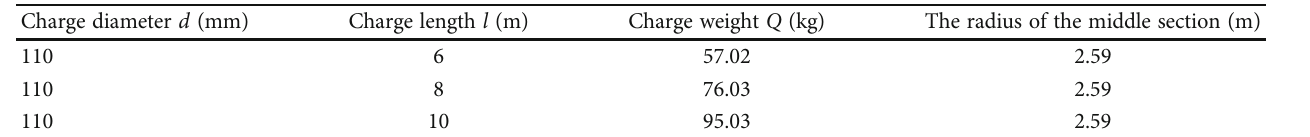
Table 4: Radius of plastic zone under di ff erent charge diameters.